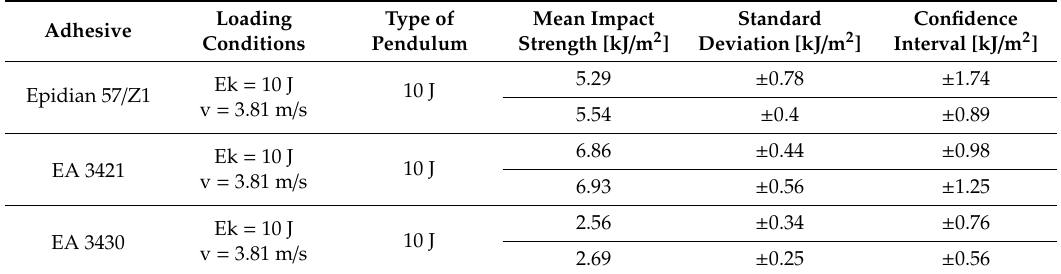
Table 1. Results of impact strength testing of samples bonded with various adhesives.